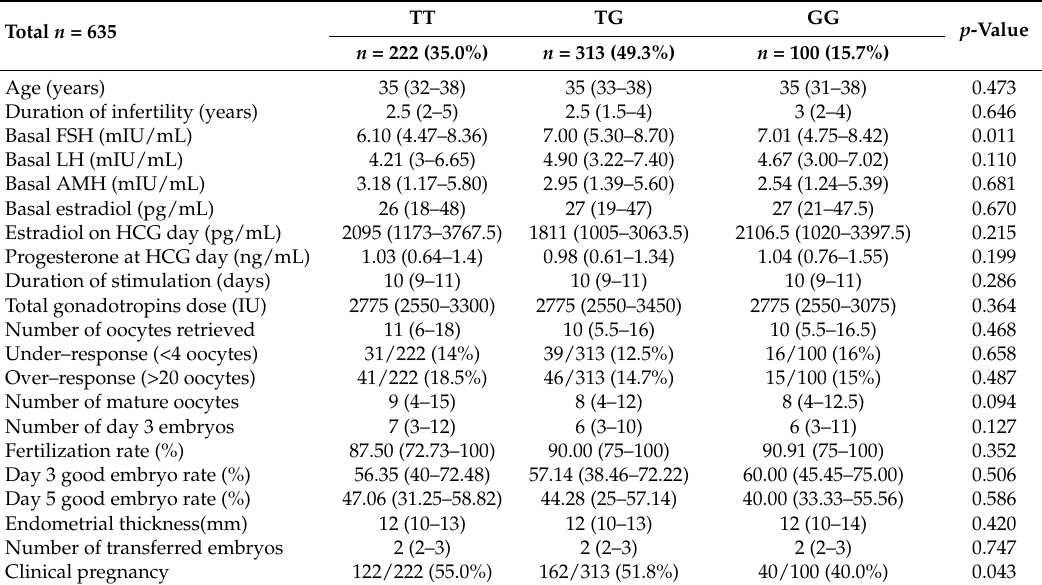
Table 1. Baseline characteristics and in vitro fertilization (IVF) treatment cycle outcomes of patients with different AMH 146 T > G (rs10407022) SNP.